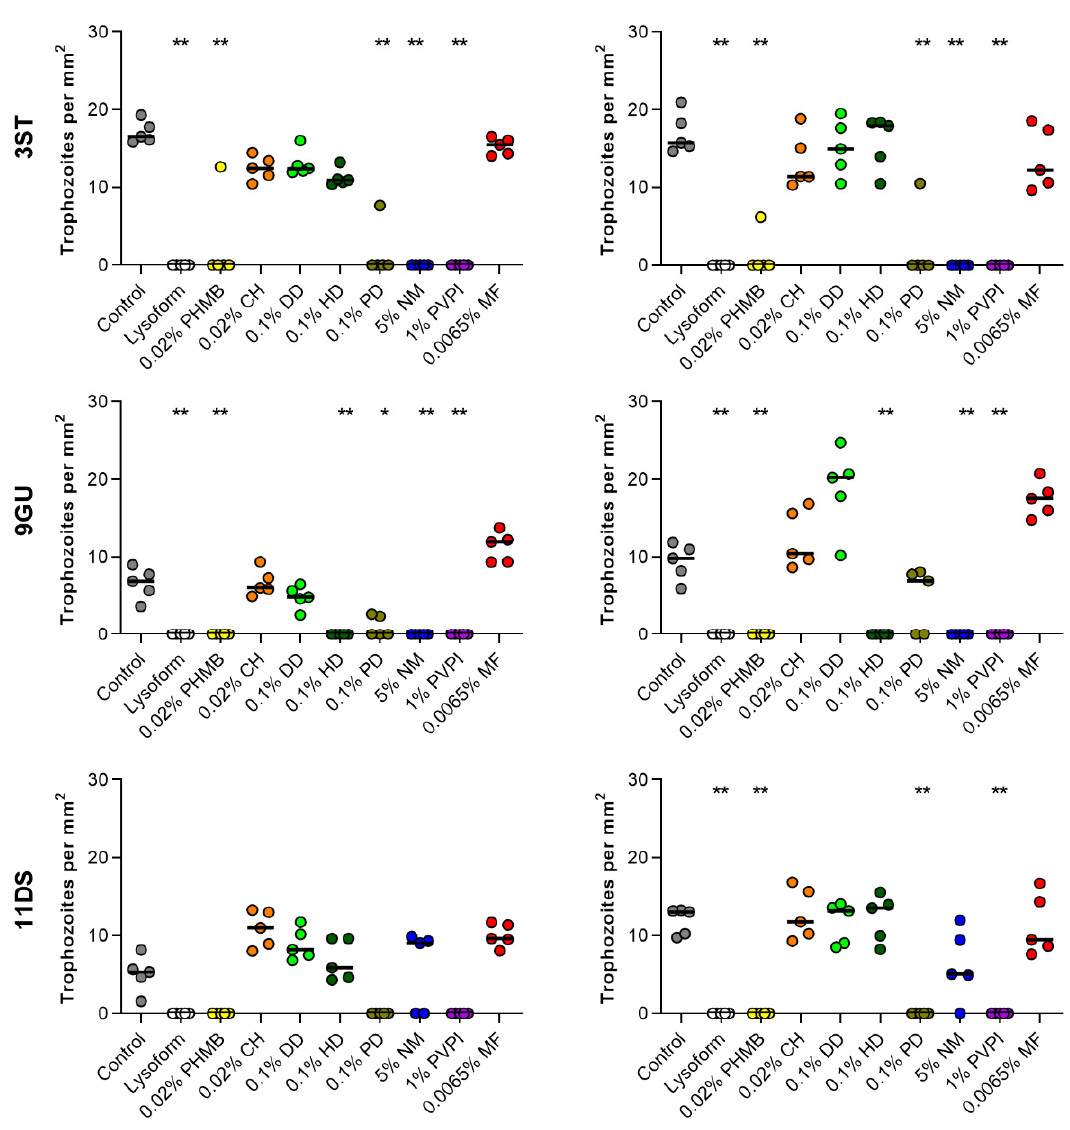
Figure 3. Impact of drug treatment on trophozoite densities of Acanthamoeba test strains on non- nutrient agar E. coli plates after 1 and 3 weeks. Data represent the median (horizontal line) and the mean trophozoite numbers per mm 2 per plate of five biological replicates. Statistical differences be- tween drug treatment groups (colored symbols) and the PBS control (gray symbols) were determined by the Kruskal–Wallis test followed by Dunn’s post hoc test. *, p < 0.05; **, p < 0.01. CH, chlorhexidine (orange); DD, dibromopropamidine diisethionate (mint green); HD, hexamidine diisethionate (dark green); MF, miltefosine (red); NM, natamycin (blue); PHMB, polyhexamethylene biguanide (yellow); PVPI, povidone iodine (purple); PD, propamidine isethionate (moss green).